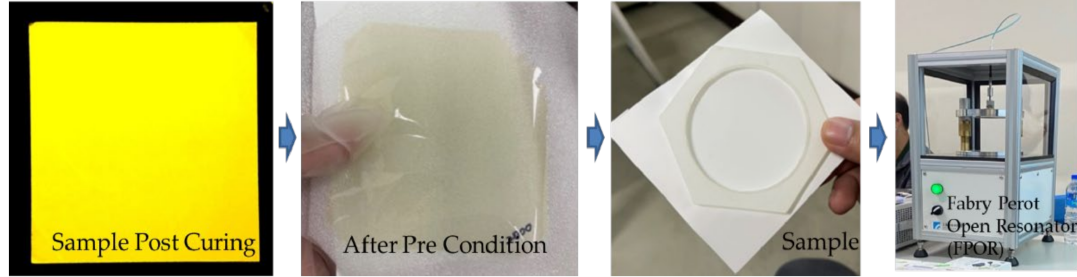
Figure 5. Fabry–Perot open resonator